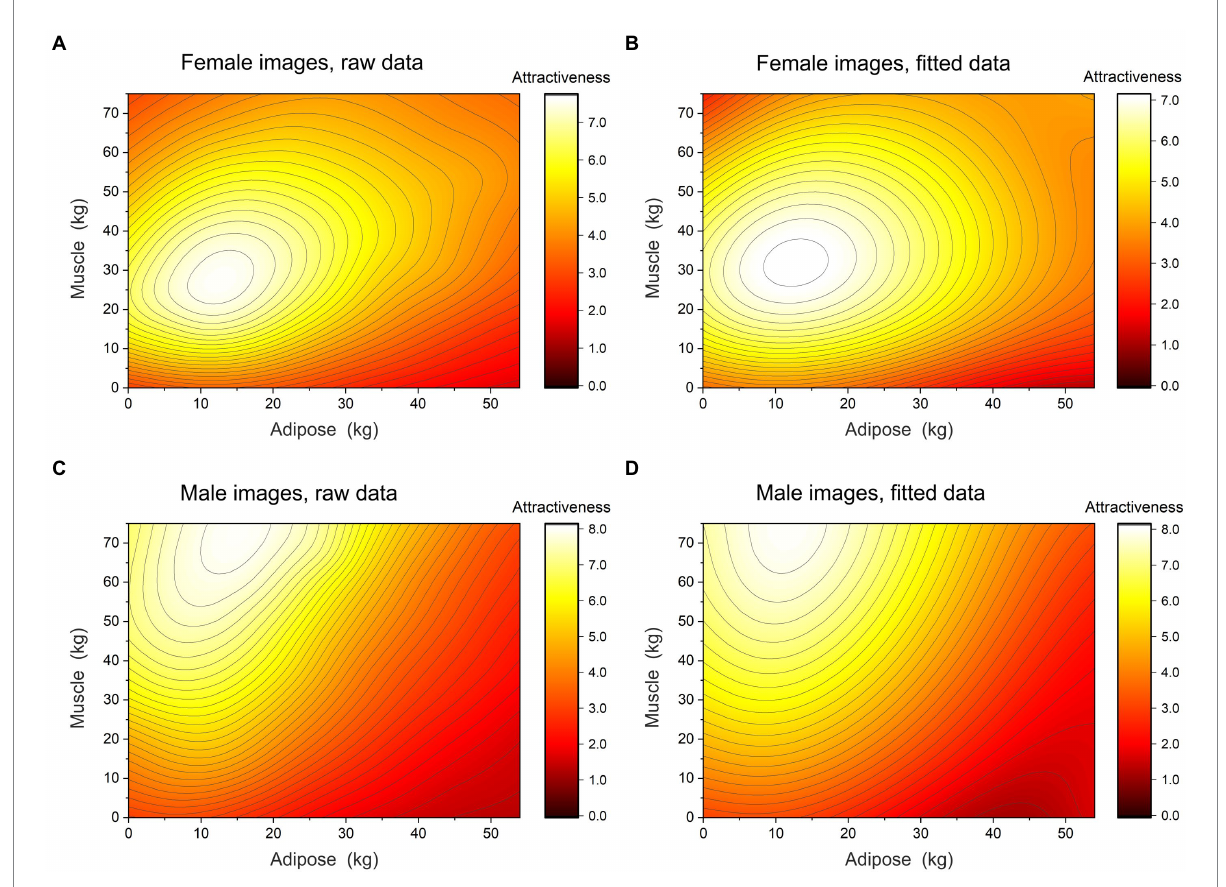
FIGURE 3 The left column shows contour plots of attractiveness as a function of muscle and adipose mass, averaged across male and female observers, separately for (A) , female and (C) , male images. The right column shows contour plots of model fitted attractiveness as a function of muscle and adipose mass, averaged across male and female observes, separately for (B) , female and (D) , male images. In each plot, attractiveness increases systematically from brown through red, and yellow to